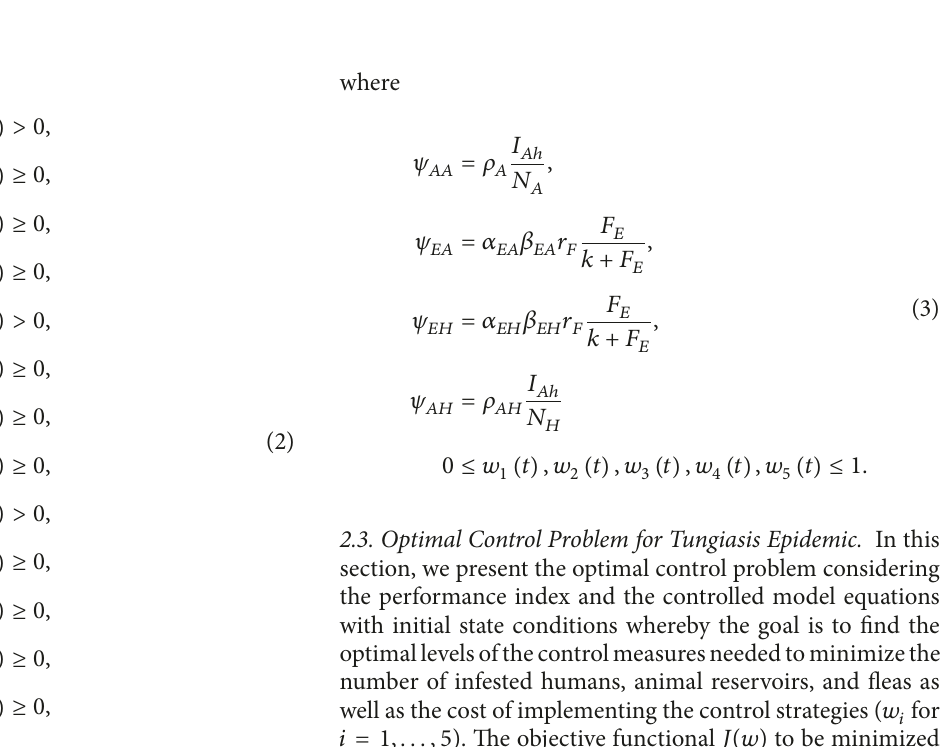
Figure 1: The flow chart showing the dynamics of Tungiasis with control measures incorporated.